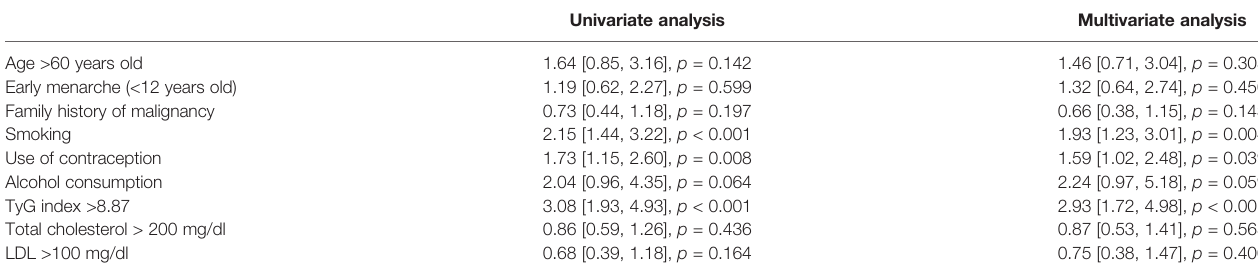
TABLE 3 | Univariate and multivariate analysis of risk factors for breast